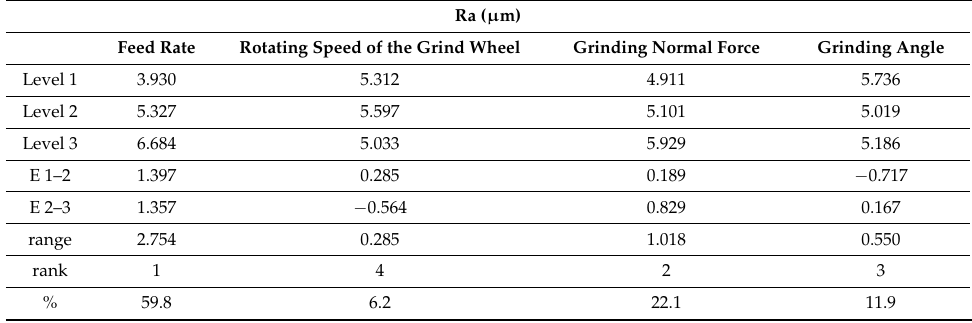
Table 3. Analysis of the grinding experimental data.